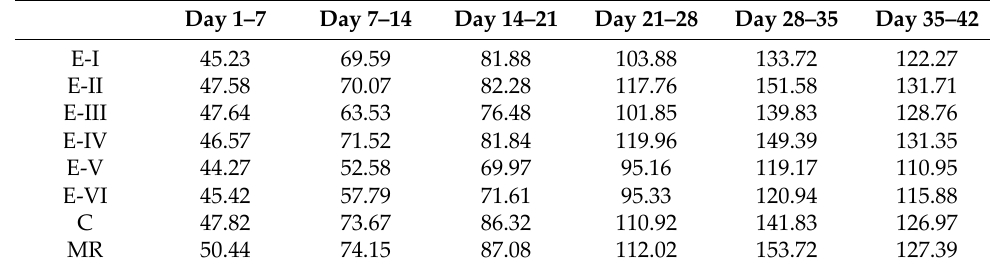
Table 4. The effects of 0.2% of MR on average daily feed intake (FI) of broiler chicks fed diets